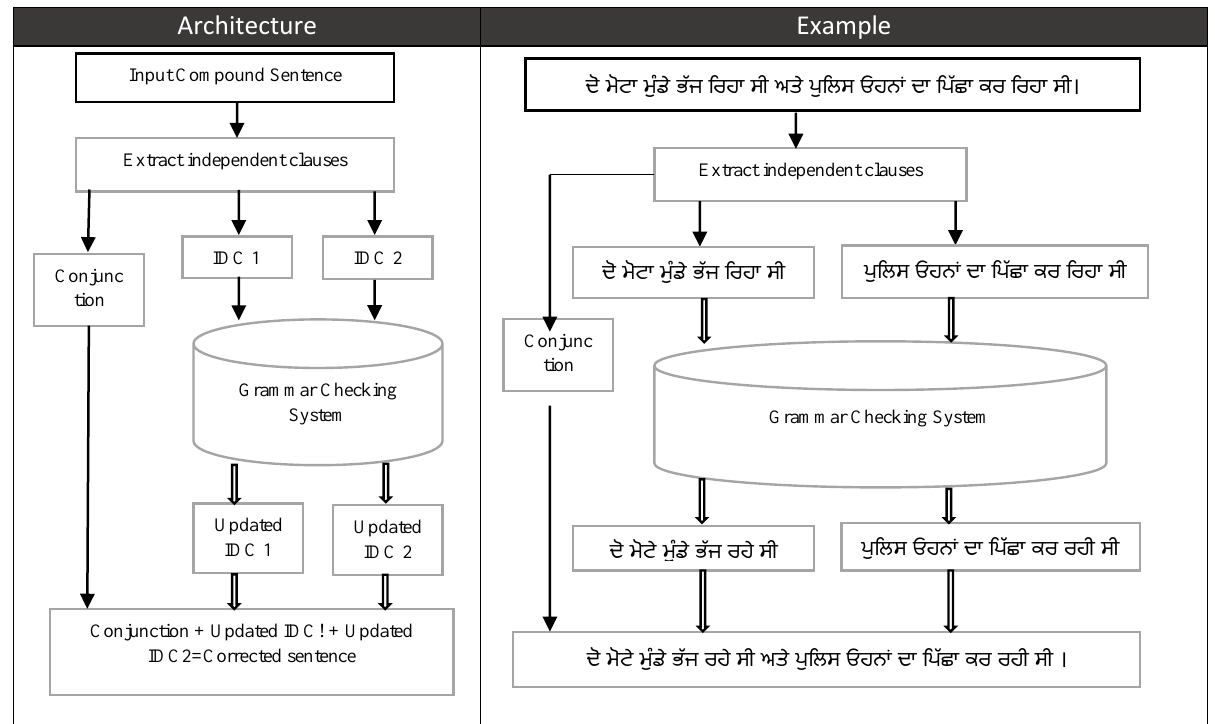
Figure 2: Architecture of grammar checking of compound